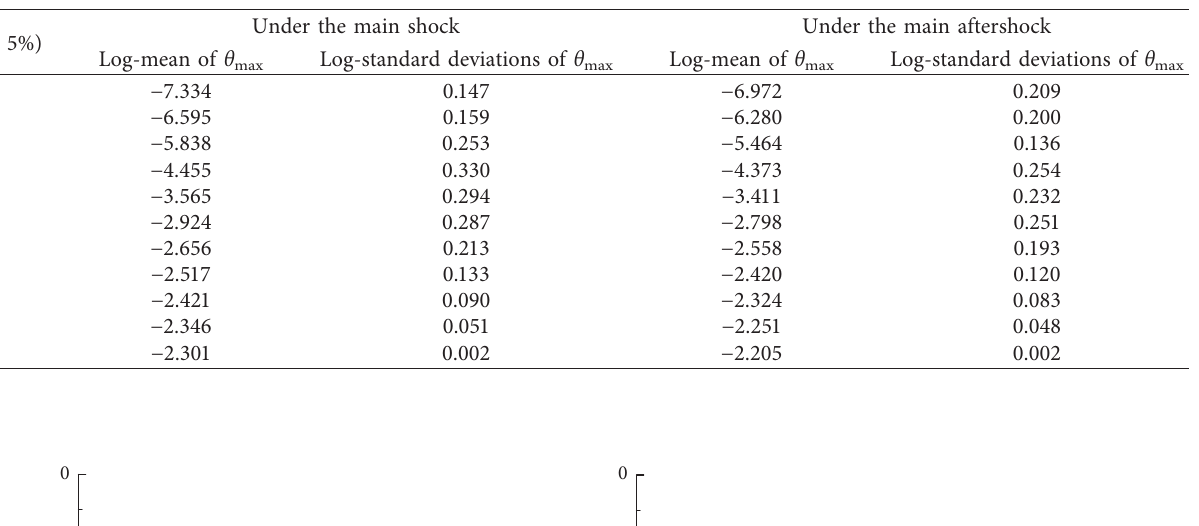
Table 5: The structural requirements.